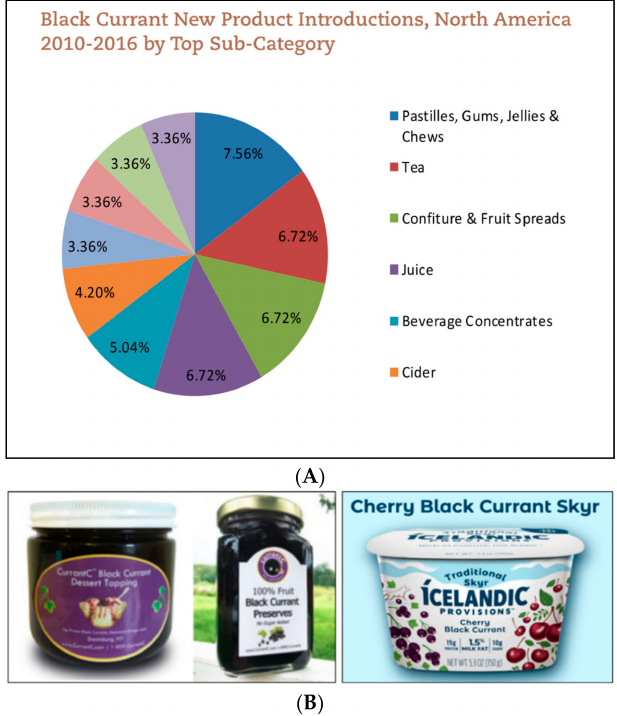
Figure 4. ( A ) Top categories of Blackcurrants products in North America [50]. ( B ) Examples of American made blackcurrants products—dessert toppings, preserves, and Skyr